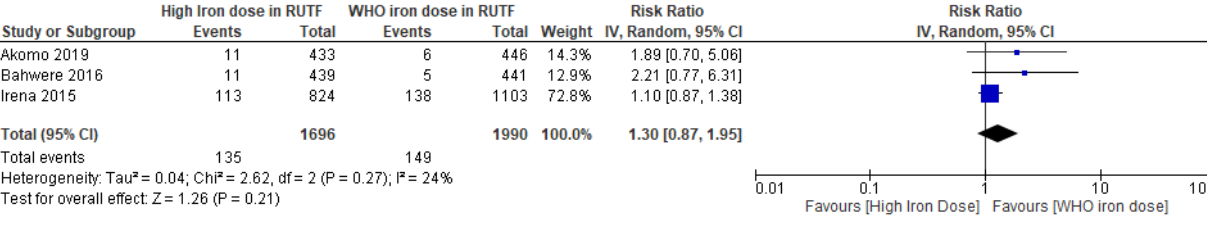
Figure 7. Effect of SMS-based RUTF with high iron content compared to that of peanut-based RUTF with WHO standard iron content on all-cause mortality. The forest plot shows pooled data from all three included studies from this review. Raw values were used, and an intention-to-treat analysis was preferred, where available. The pooled results show a potential increase in mortality for children receiving RUTF with high iron content, compared to RUTF with WHO standard iron content. Akomo 2019 [4]. has two study groups. We included data from milk-free